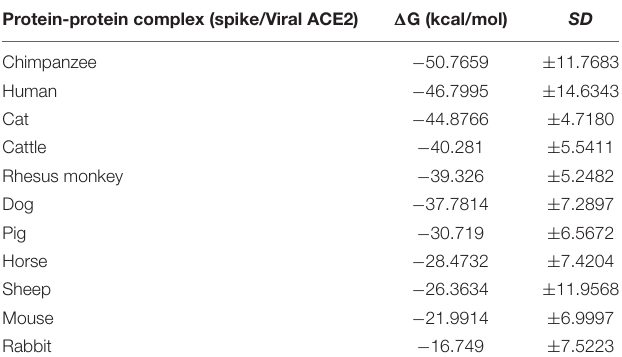
TABLE 2 | Binding affinity ( (cid:49) G) predicted values for the interaction between spike and viral ACE2 receptor. Protein-protein complex (spike/Viral ACE2) (cid:49) G